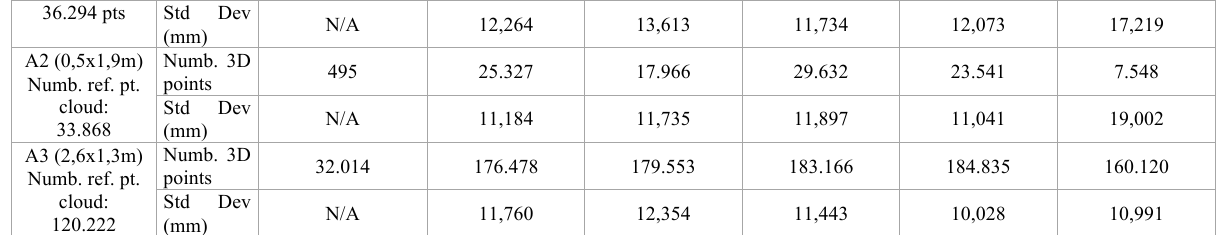
Table 3: Dense matching results and evaluation of the denoising methods applied to the enhanced dataset. The ground truth is given by a TLS survey resampled to 5x5 mm grid.